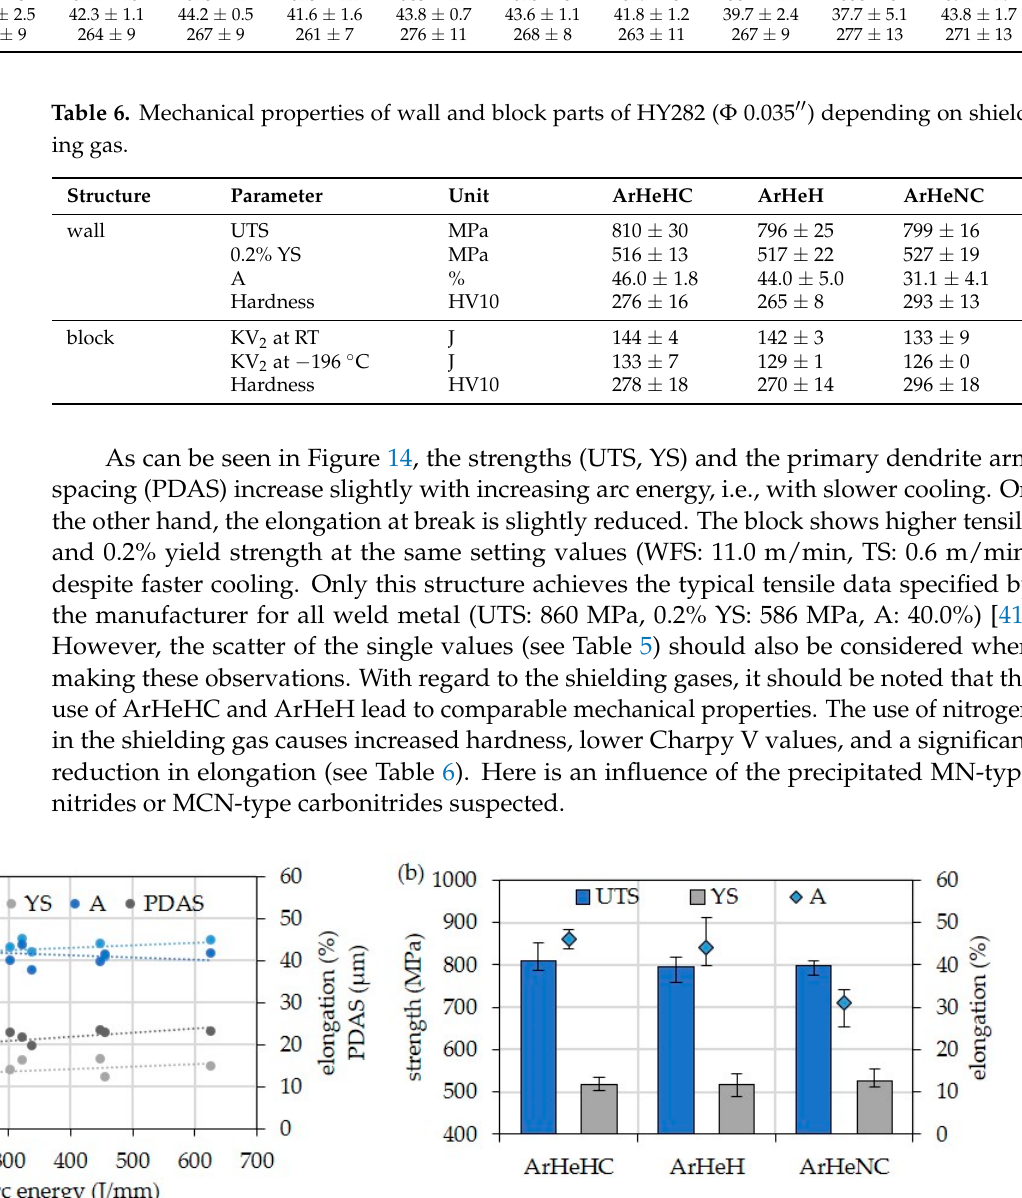
Table 5. Mechanical properties of wall and block parts of HY282 ( Φ 0.04 ″ ) depending on arc energy.